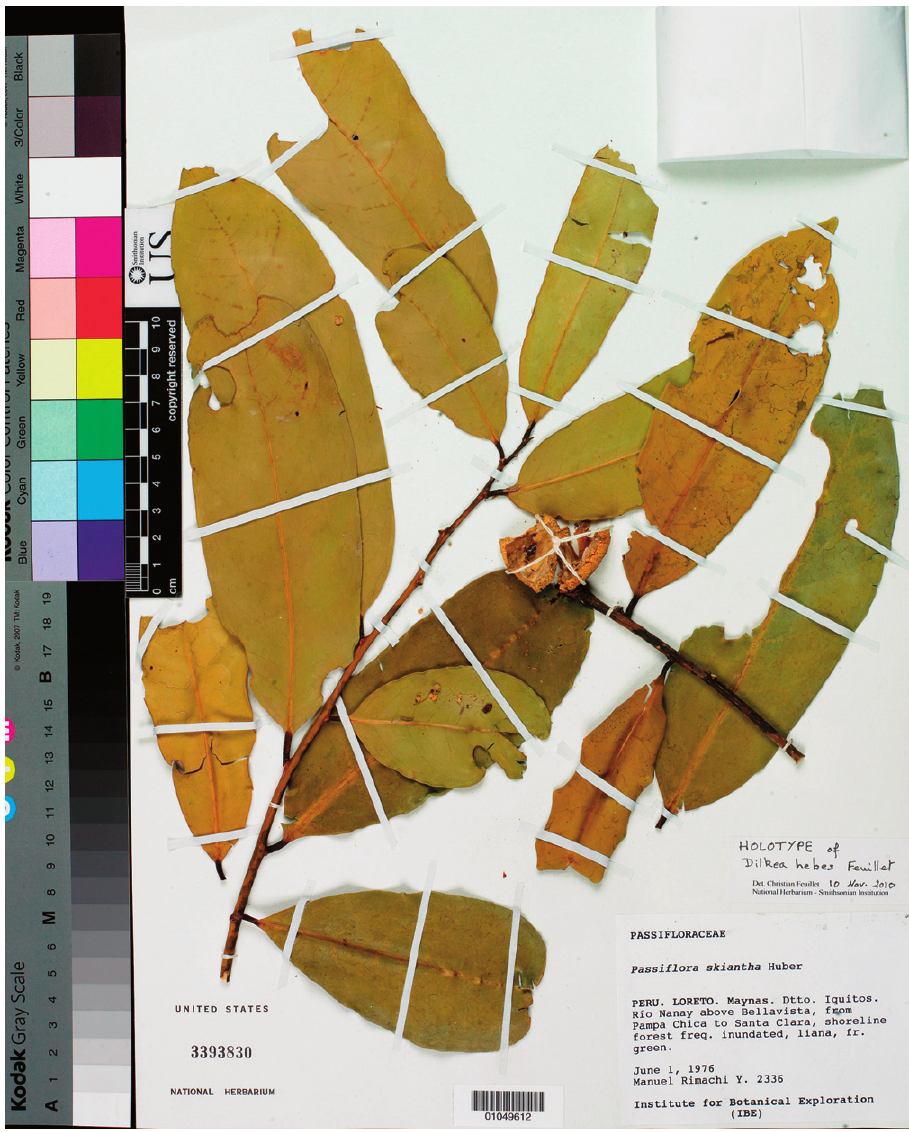
Figure 1. Holotype of Dilkea hebes Feuillet: M. Rimachi Y. 2336